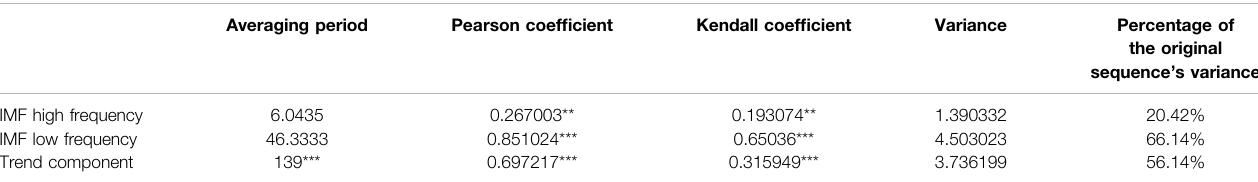
TABLE 3 | Statistical information of each component after